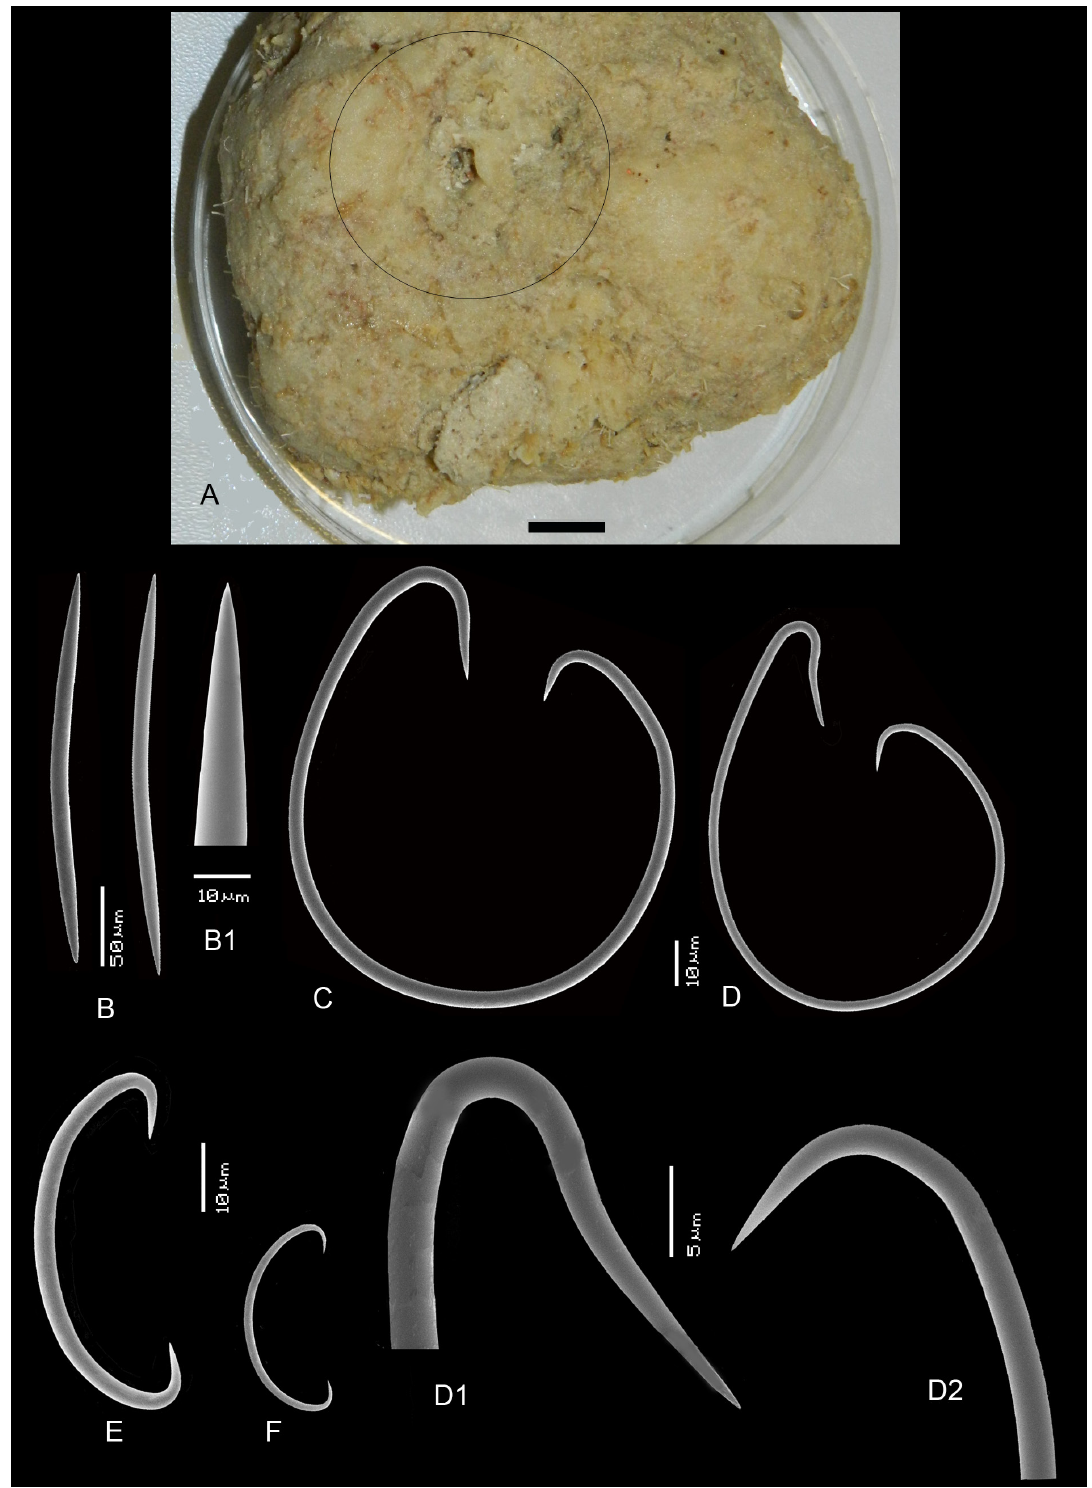
Fig. 10. Haliclona ( Flagellia ) amirantensis subgen. et sp. nov., holotype (ZMA Por. 12409), from Desnoeufs Island, Amirantes, Seychelles. A . Habitus (encircled) encrusting a large Topsentia specimen (scale bar = 1 cm). B–F . SEM images of the spicules. B . Oxeas. B . Detail of one of the 1 apices. C–D . Flagellosigmas. D . Detail of long ending of flagellosigma. D . Detail of short ending of 1 2 flagellosigma. E . Large sigma category (I). F . Small sigma category